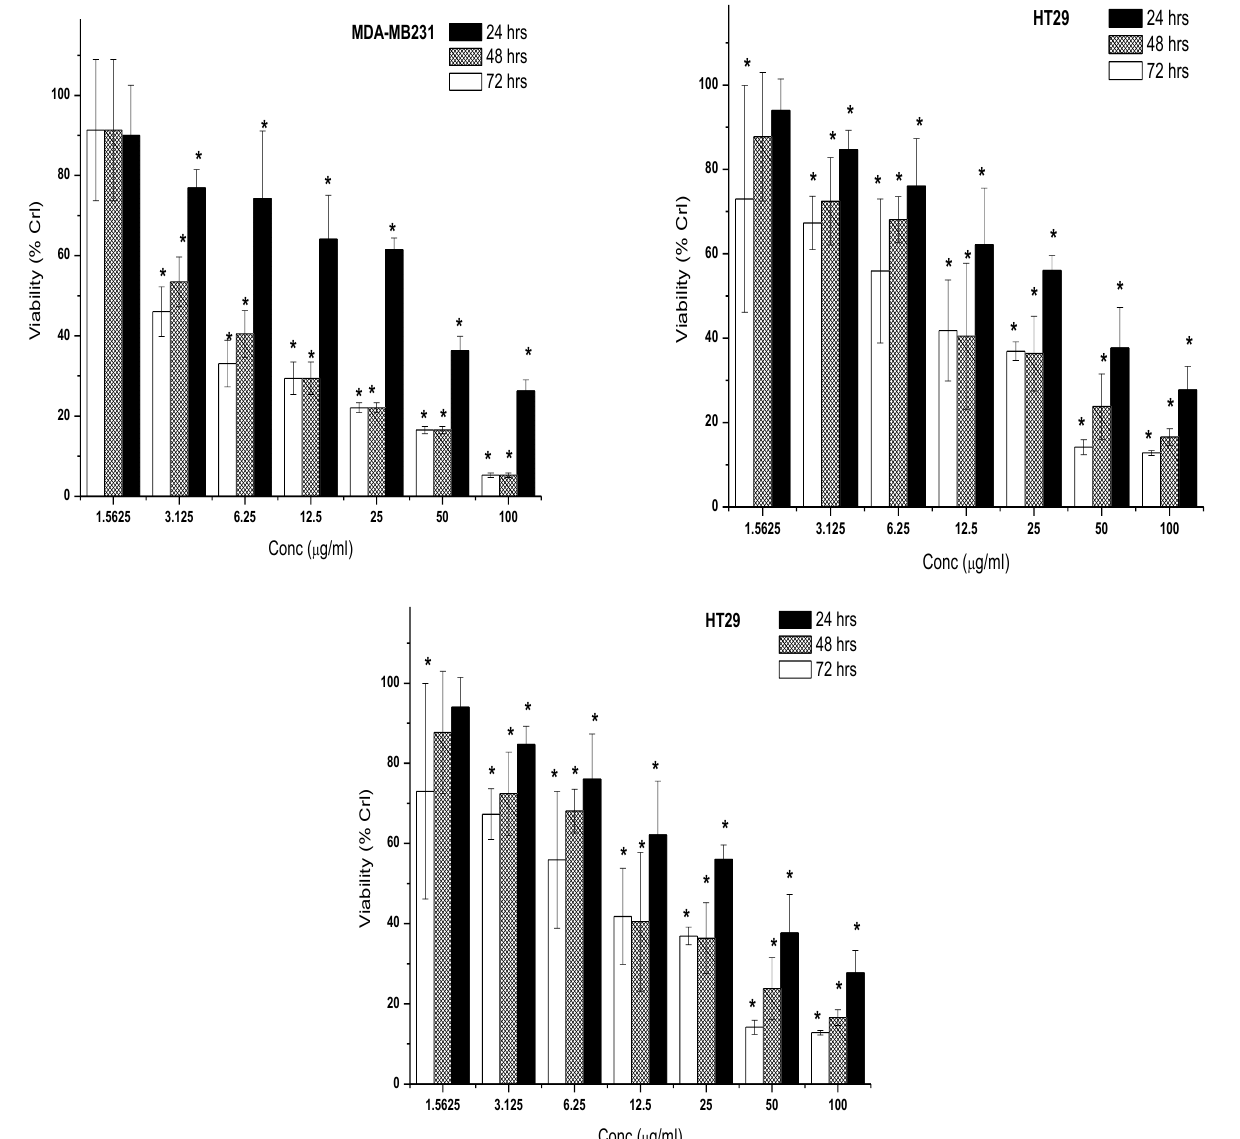
Table 4. With respect to selectivity index (SI), 7-geranyloxycinnamic acid recorded the SI value of (SI > 2) as shown in Table 5.